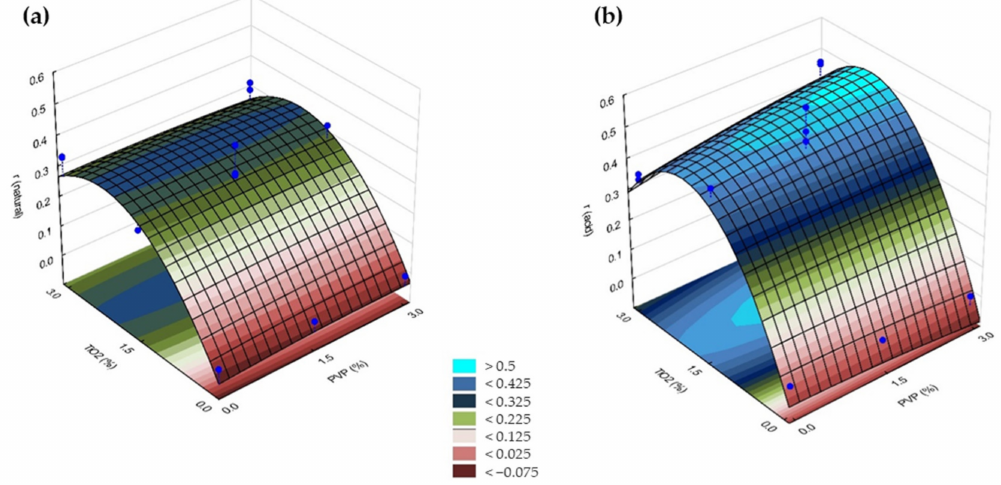
Figure 7. Fitted surfaces of reaction rate (r) responses obtained by varying the concentration of PVP for the membranes containing TiO 2 at different concentrations under ( a ) natural and ( b ) acidic conditions. Blue dots represent experimental values within the investigated design space ( n =